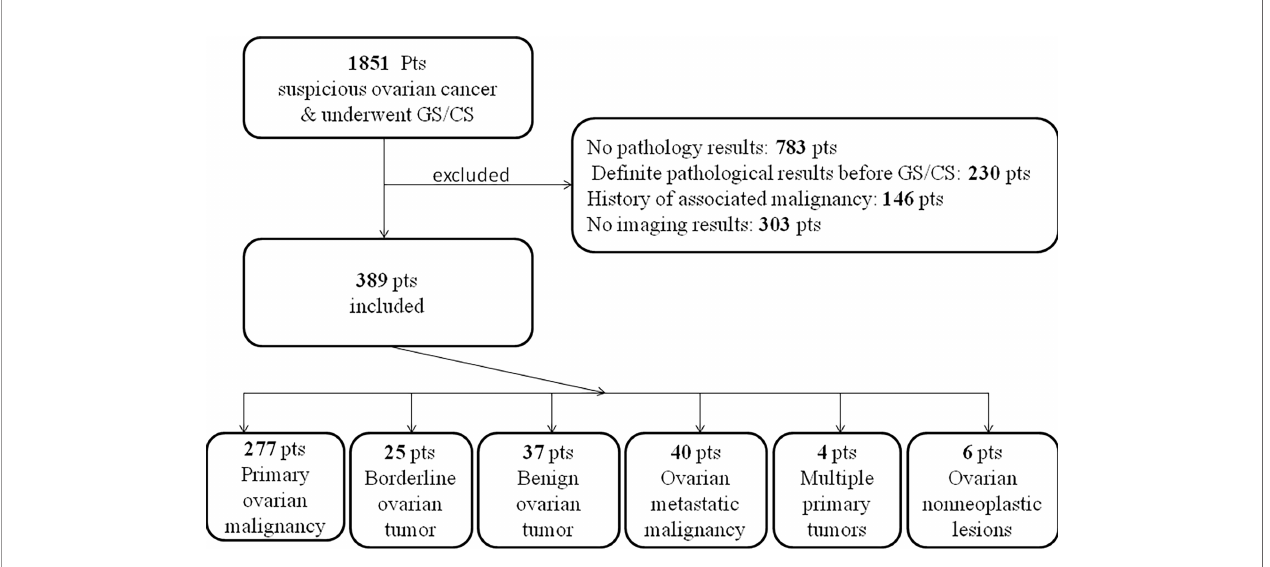
FIGURE 1 | Flow diagram of patient selection and fi nal diagnosis.